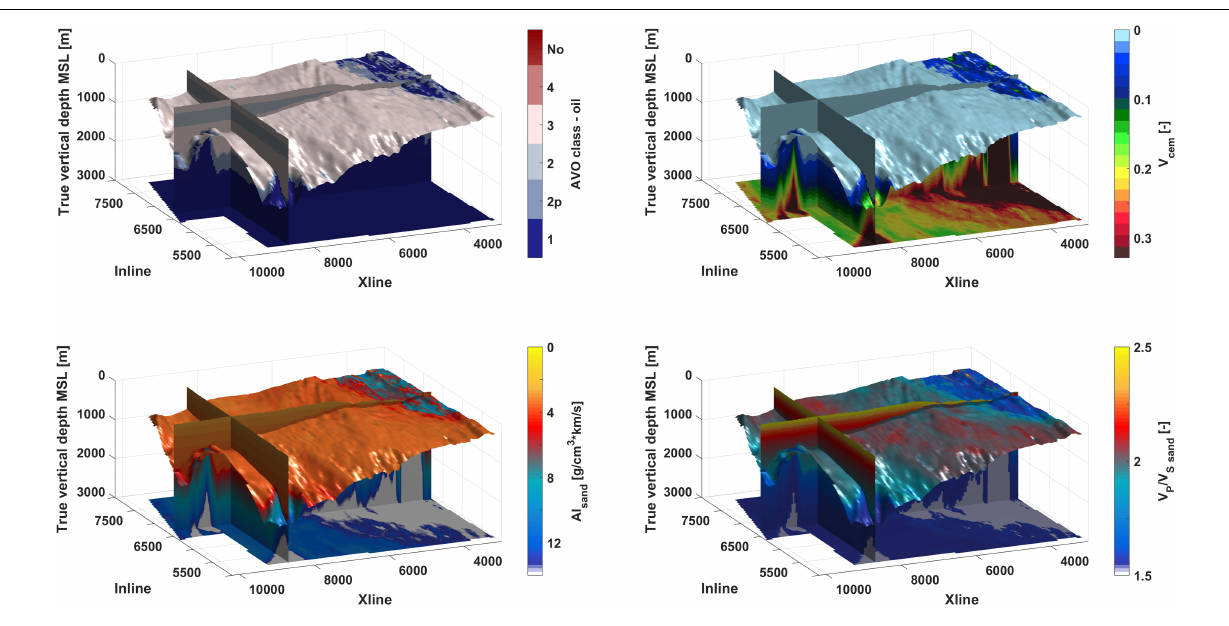
Frontiers in Earth Science |